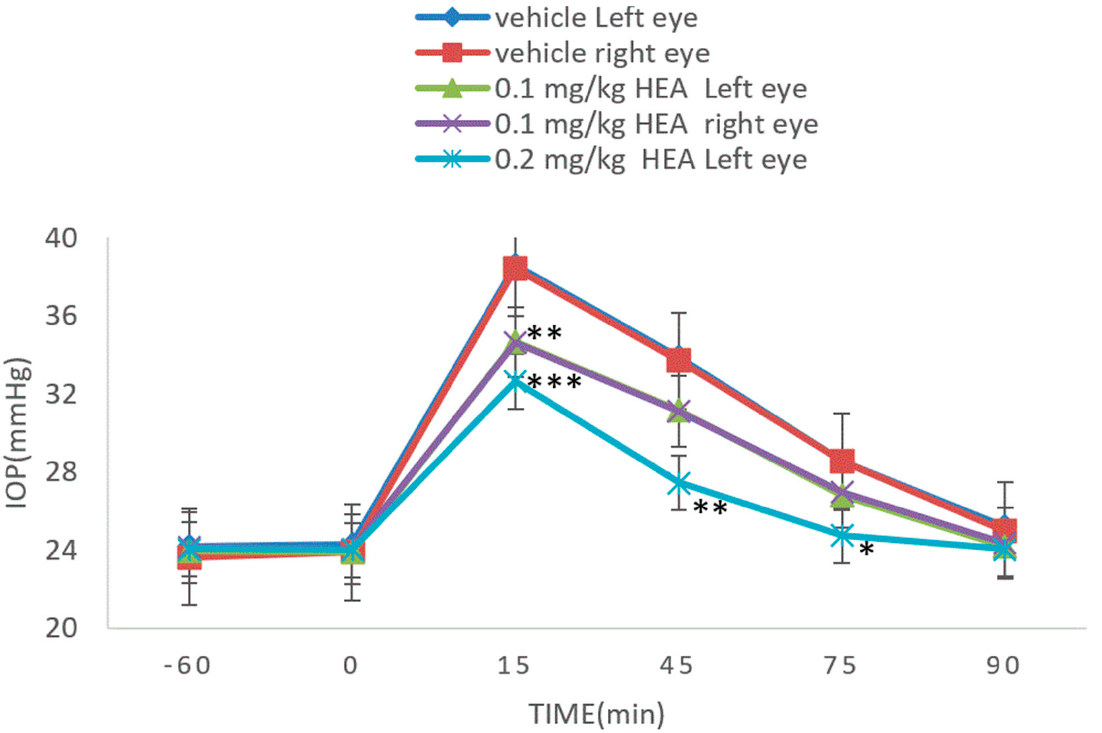
Figure 7. Anti-hypertensive IOP effect of HEA in dextrose induced acute glaucoma rabbit (A = 0.1 mg/kg/b.w., B = 0.2 mg/kg/b.w., n = 4). * p < 0.05, ** p < 0.01 and *** p < 0.001, compared with solvent control group.